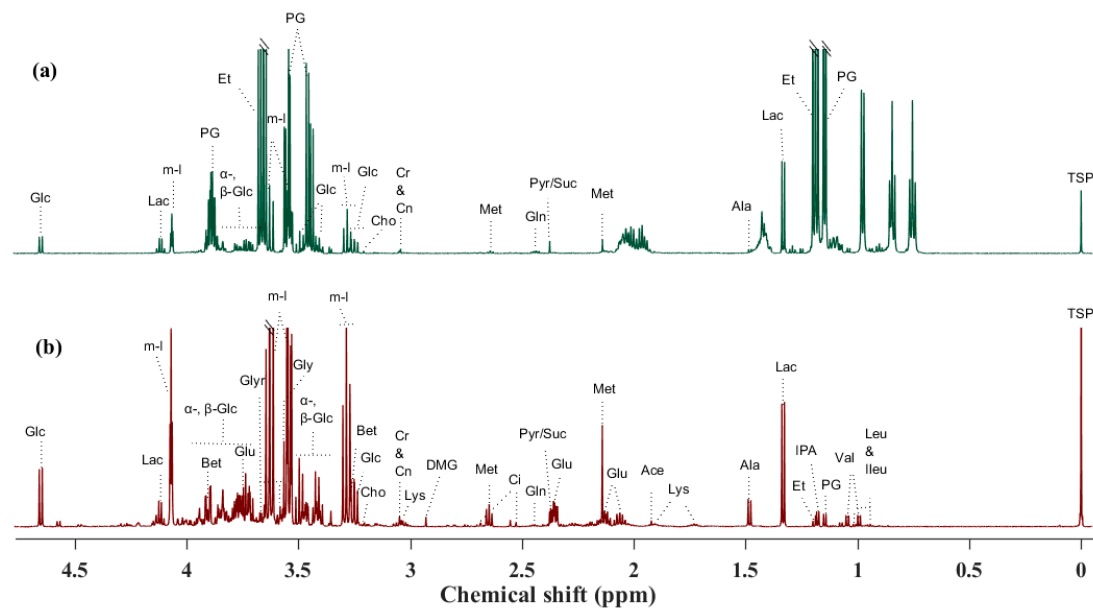
Figure 1. 1 H NMR spectra (obtained at 600 MHz) of a control sample and the identified metabolites: ( a ) cerebrospinal fluid (CSF) and ( b ) plasma. Abbreviations: Ace: acetate; Ala: alanine; Bet: betaine;